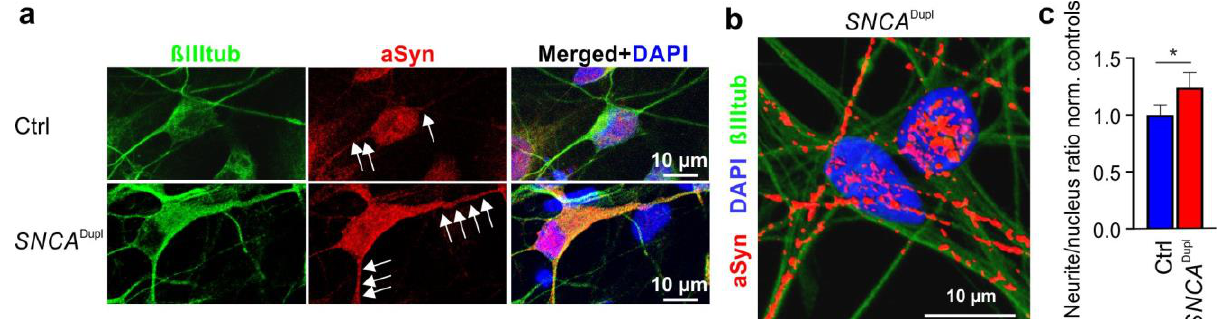
Figure 6. ICC analysis of aSyn distribution in mDANs from healthy controls (Ctrl) and a SNCA Dupl patient. ( a ) Representative immunofluorescence images of mDANs differentiated for 21 days labelled with the Nu-aSyn-C antibody, anti- βIIItub, and DAPI. The corresponding TH staining is shown in Figure S5. ( b ) Representative reconstructed 3D image highlights intense aSyn immunosignals along the neurites of SNCA Dupl mDANs. ( c ) Quantification of neurite/nucleus ratios of aSyn immunosignal intensity in SNCA Dupl mDANs normalized to the average ratio in control-derived neurons. For quantification, data represent the mean ± SD of >10 neurons of each hiPSC line in three independent experiments. Three hiPSC cell lines from three healthy individuals (UKERi33Q-R1-006, UKERiO3H-R1-001, and UKERi82A-S1-017) and two hiPSC lines (CSC-1A and CSC-1D) from the SNCA Dupl patient were used. Statistics: Two-way ANOVA, Tukey’s multiple comparisons test * p < 0.05.